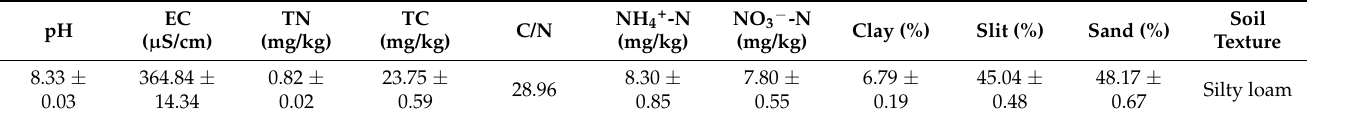
Table 1. Soil properties for incubation experiment.